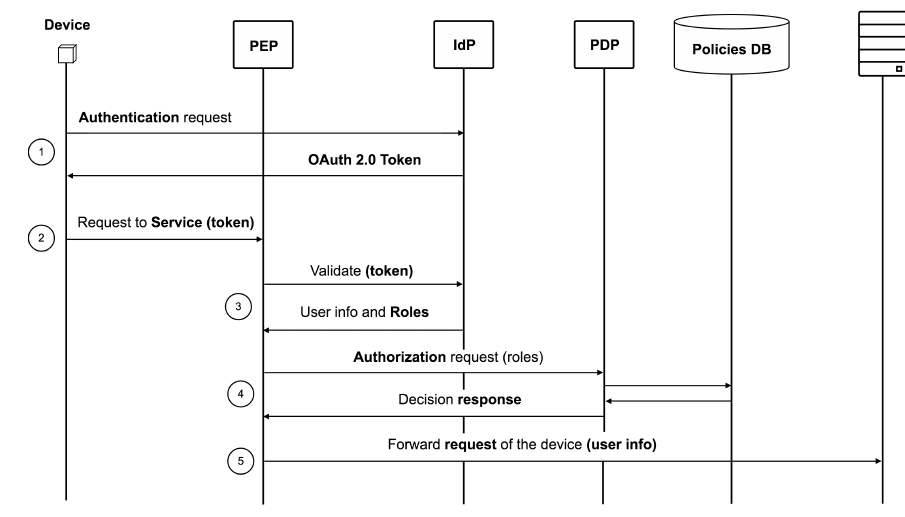
Figure 3. Device request and authorization